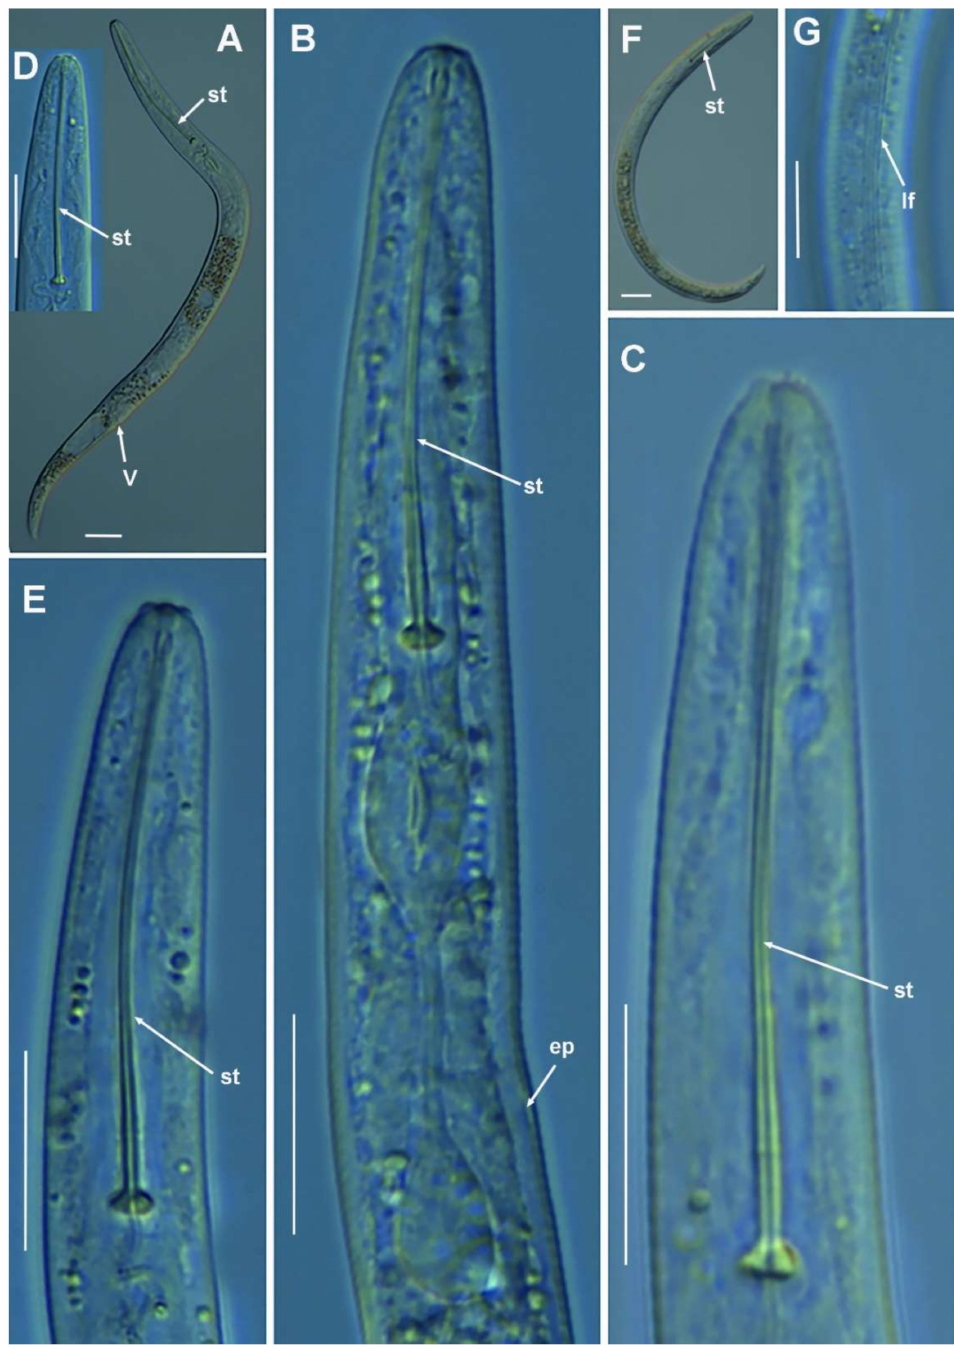
Figure 14. Light photomicrographs of Paratylenchus vitecus (Pramodini et al., 2006) Ghaderi et al., 2014. ( A ) Entire female with stylet and vulva arrowed; ( B ) female pharyngeal region with stylet and excretory pore arrowed; ( C – E ) female lip region; ( F ) entire fourth-stage juvenile with stylet arrowed; ( G ) detail of lateral field at mid-body (arrowed). Scale bars ( A – G = 20 µ m). (Abbreviations: ep = excretory pore; lf = lateral field; st = stylet; V =